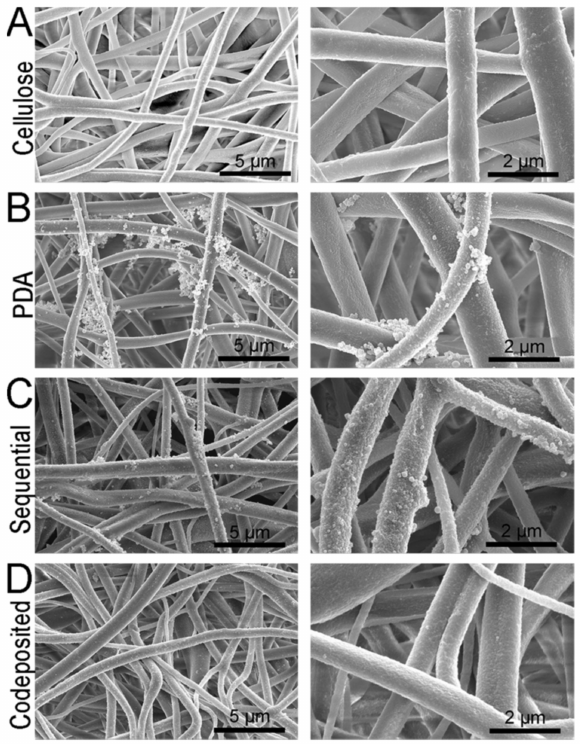
Figure 11. ( A ) SEM micrographs of the cellulose nanofiber mats used as the base materials for this study. The morphologies of ( B ) PDA and ( C , D ) polyMPC/PDA (sequential and co-deposited) functionalized nanofiber mats are also displayed. Provided with permission from American Chemical Society